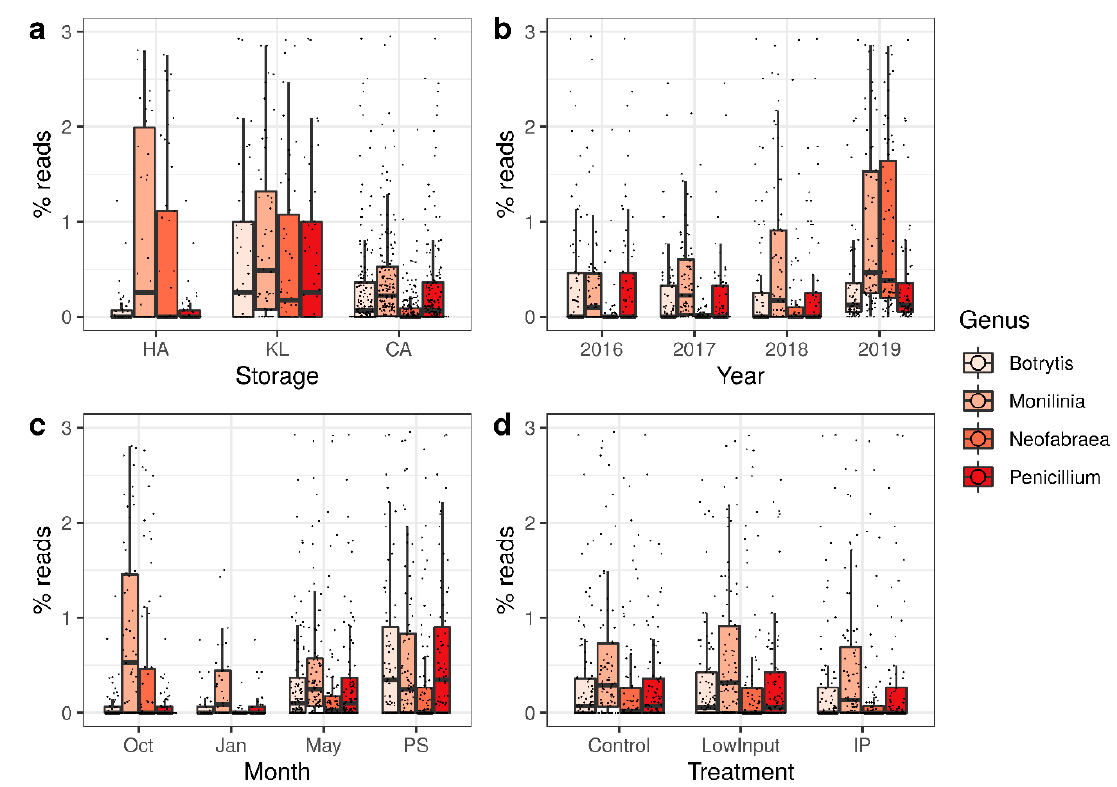
Figure 4. The percentage of reads mapping to selected pathogens causing significant economic losses in commercial storage facilities. ( a ) Variation of single read numbers between the three different storage regimes. ( b ) Variation of single read numbers over storage seasons. ( c ) Variation of single read numbers over sampling time points within storage seasons. ( d ) Variation of single read numbers between the different plant protection treatments.